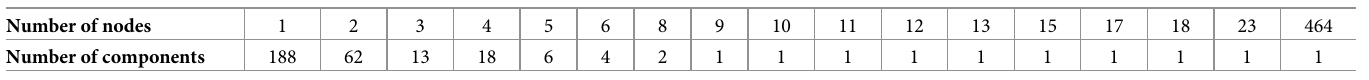
Table 1. Characteristics of the components obtained from DAG.